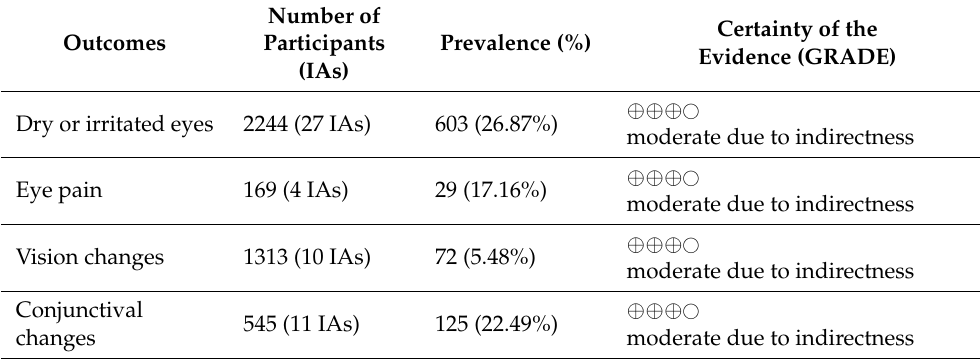
Table 4. Summary of ISO therapy adverse events: ophthalmic